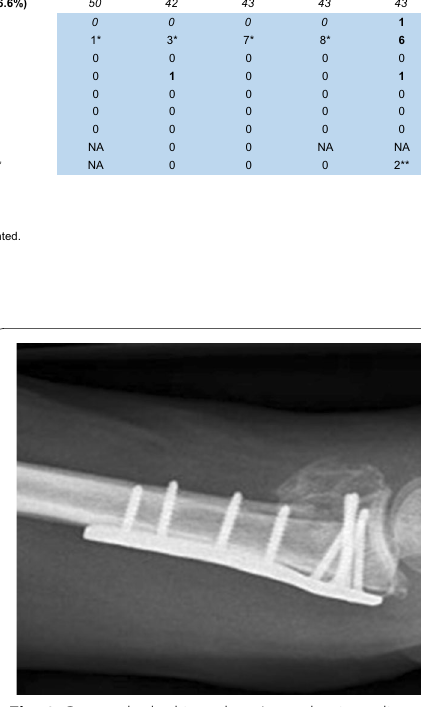
Fig. 2 Bent volar locking plate. Lateral wrist radiograph of an operatively treated distal radius fracture patient after a new fall causing a re-fracture and bending of the volar locking plate. This was a new trauma and therefore not accounted for as a